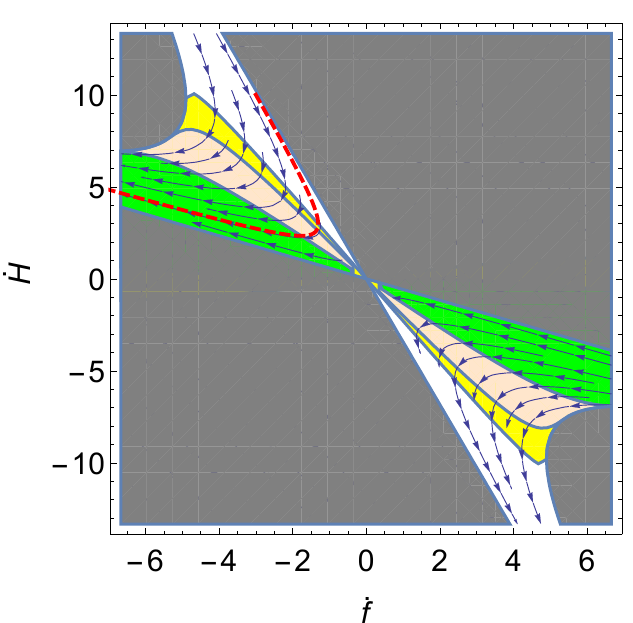
Figure 3 . The (cid:13)ow of solutions with e (cid:0) 2 f = X + : the red dashed line depicts a solution curve shown in (cid:12)gure 5. Each subregion denotes: white ( (cid:127) f > 0, (cid:127) a < 0, (cid:127) H < 0), yellow ( (cid:127) f < 0, (cid:127) a < 0, (cid:127) H < 0), light orange ( (cid:127) f < 0, (cid:127) a > 0, (cid:127) H < 0), and green ( (cid:127) f < 0, (cid:127) a > 0, (cid:127) H > 0).